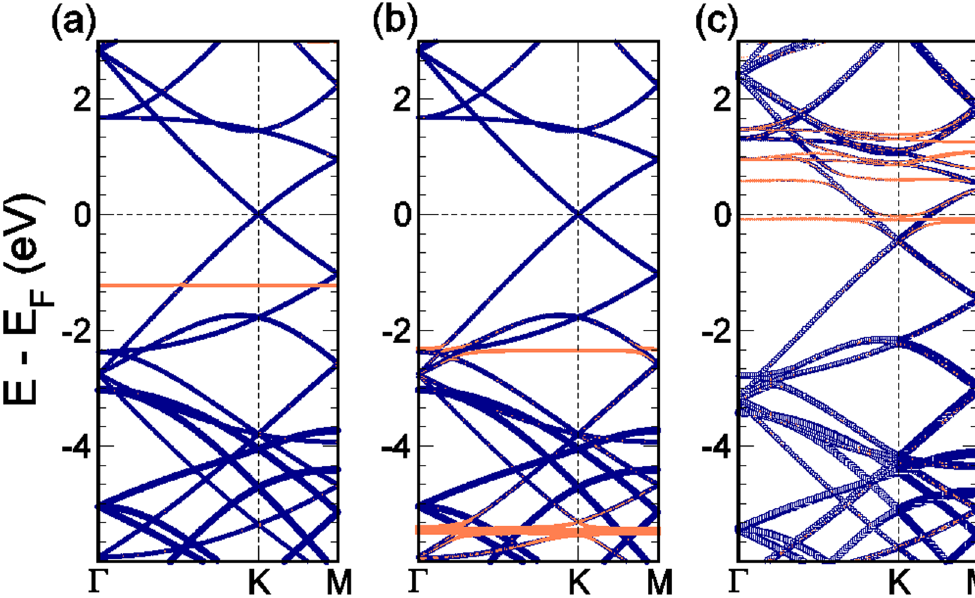
Figure 3. Band structure of ( a ) Cd, ( b ) Hg and ( c ) Pb atoms adsorbed on a 4 × 4 graphene supercell. The purple lines denote those bands with a large graphene character, while the orange lines have a higher character from the metal adatom. This band character was determined by projecting onto the atomic orbitals of the respective atoms. The band thickness represents the magnitude of the overlap.